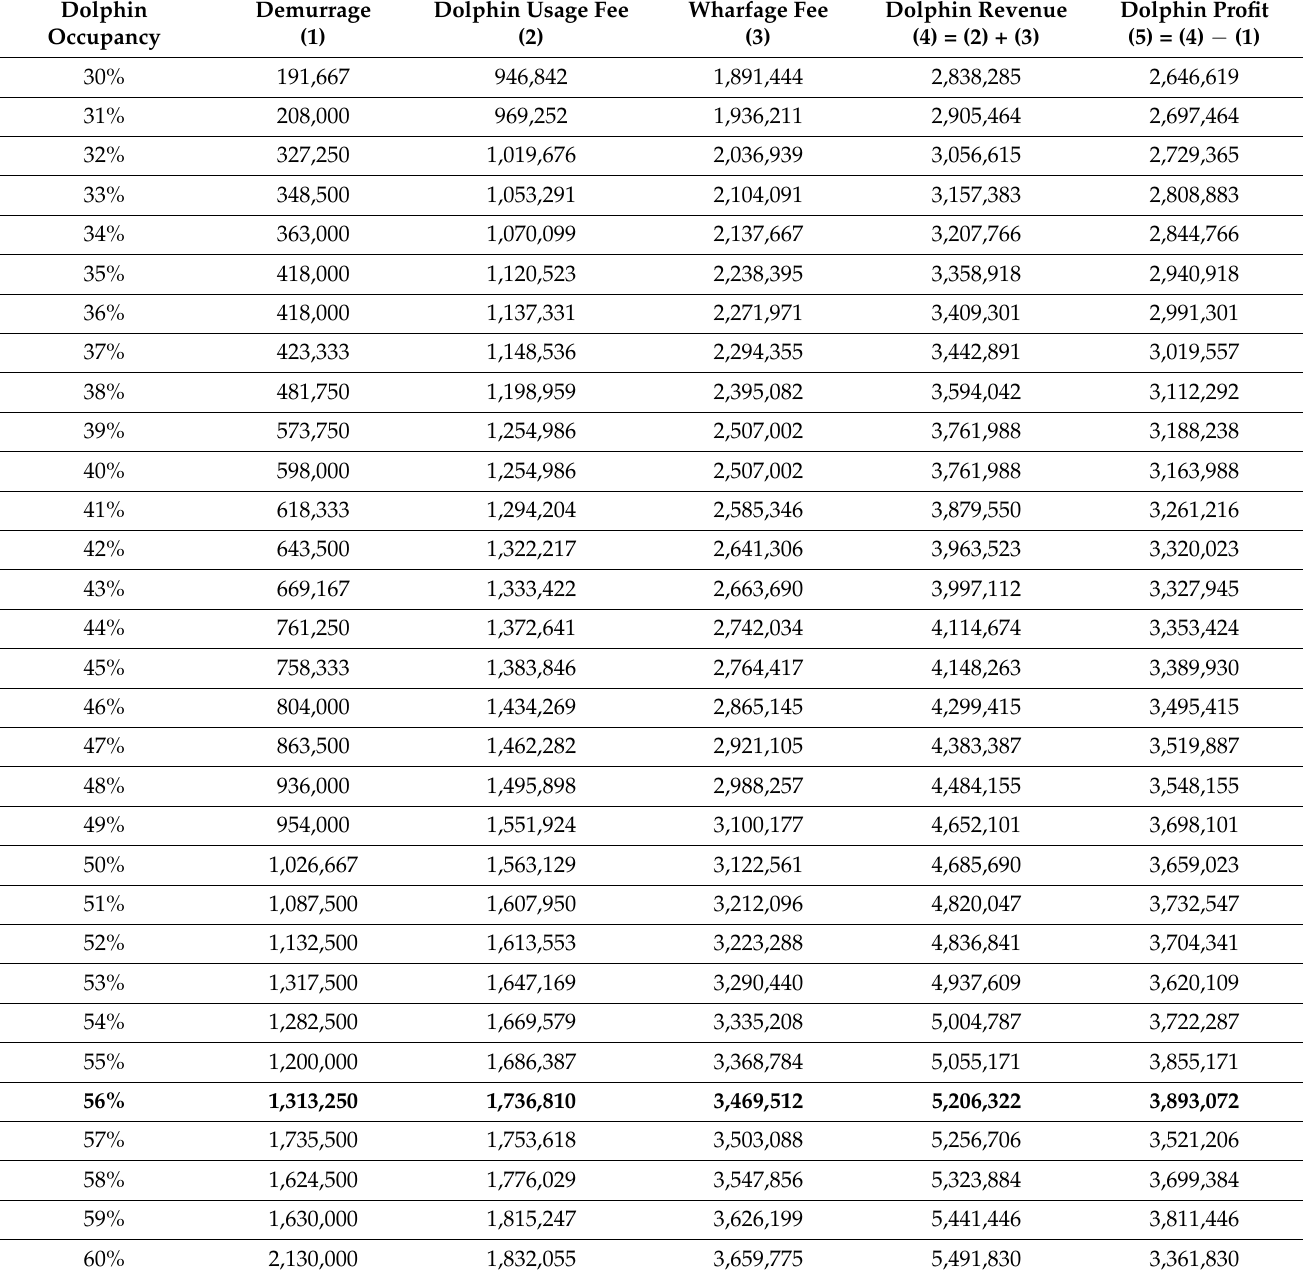
Table 7. Dolphin profit and occupancy with USD 20,000 demurrage per